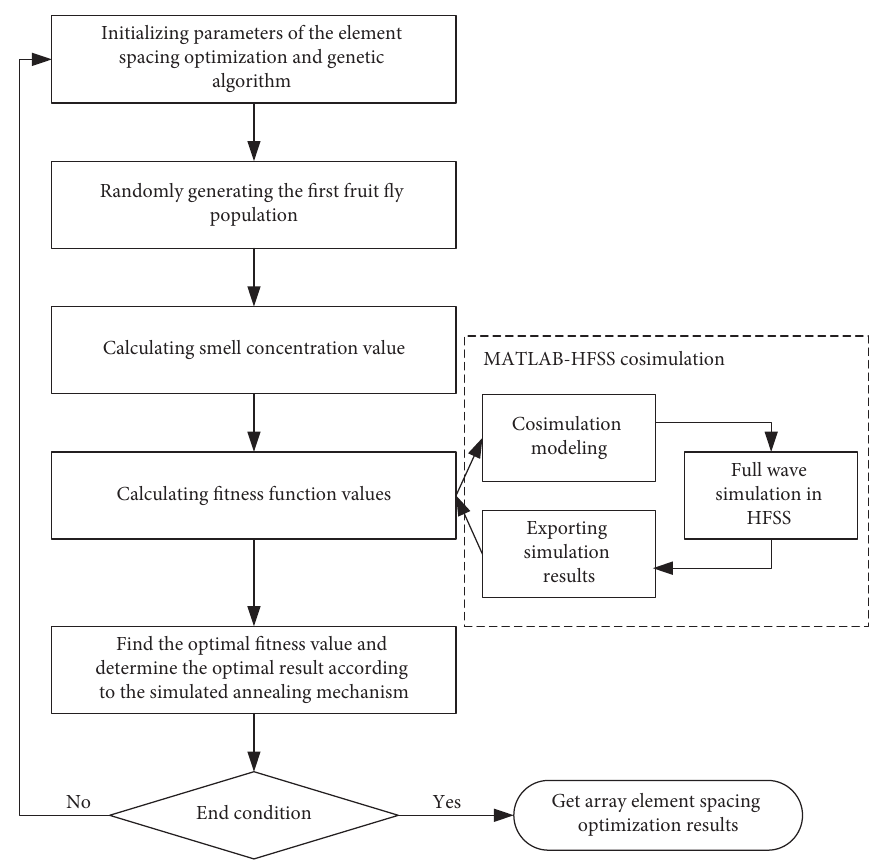
Figure 8: Flowchart of spacing optimization of the linear irregular FRAA elements.